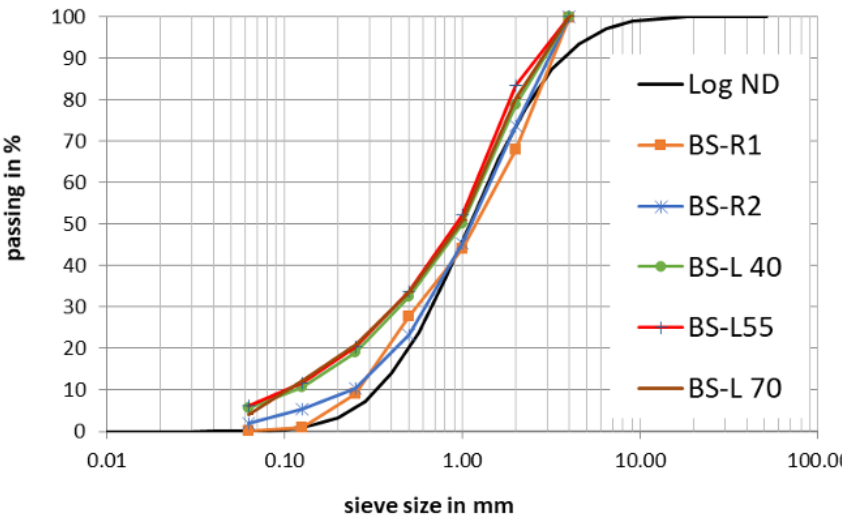
Figure 5. Particle size distribution of crushed